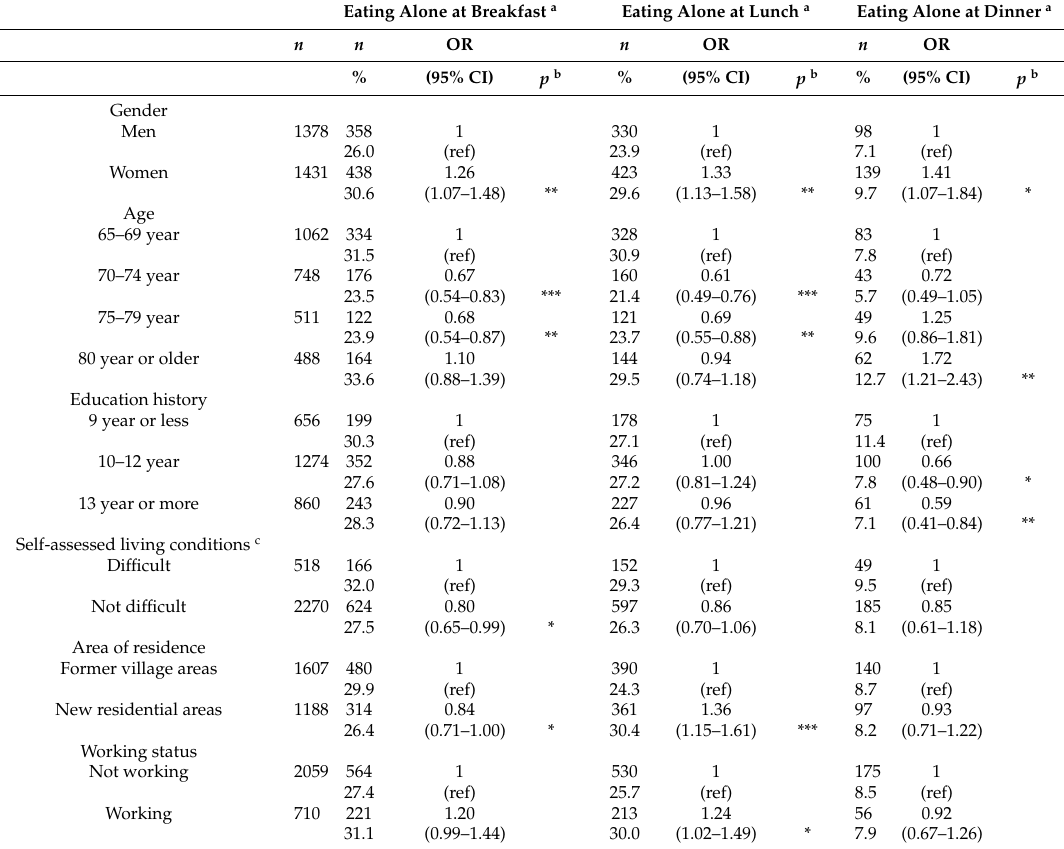
Table 1. Association of socio-demographic characteristics with eating alone at each meal ( n =